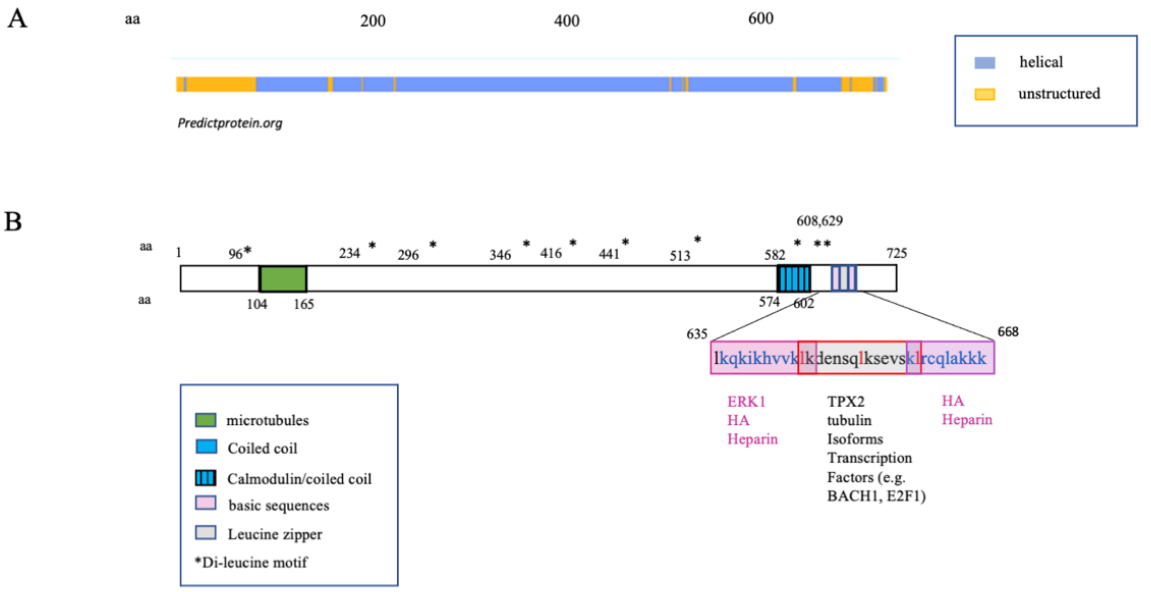
(predictprotein.org (accessed: 18 September 2021)) and ( B ) the major binding domains identified to date occur in the alpha- Figure 2. The predicted secondary structure of human RHAMM ( A ) and the known binding domains for which binding